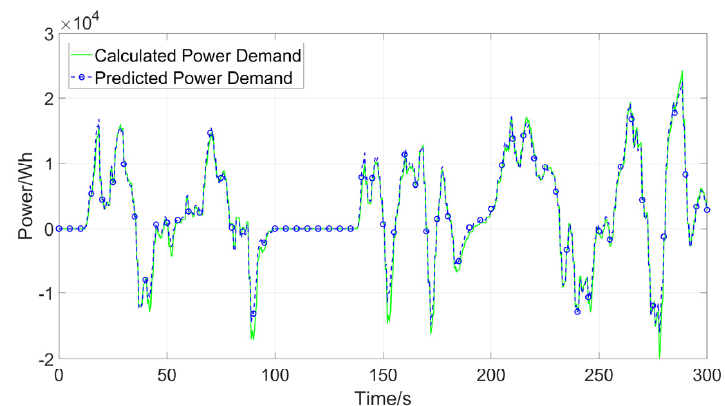
Figure 10. Power demand prediction result.